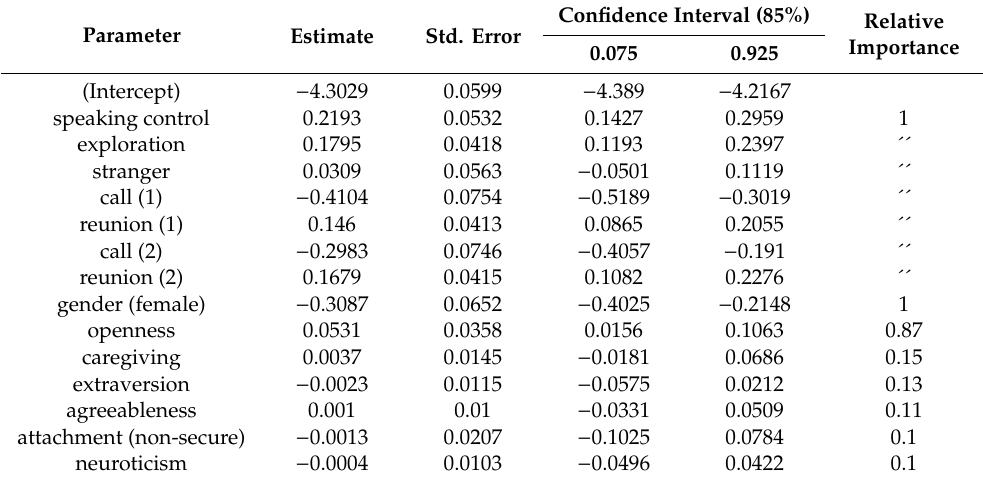
Table 3. Model averaged coe ffi cients for jitter models. Only variables with a minimum relative importance of > 0.8 and a confidence interval not ranging over 0 are taken into consideration for model